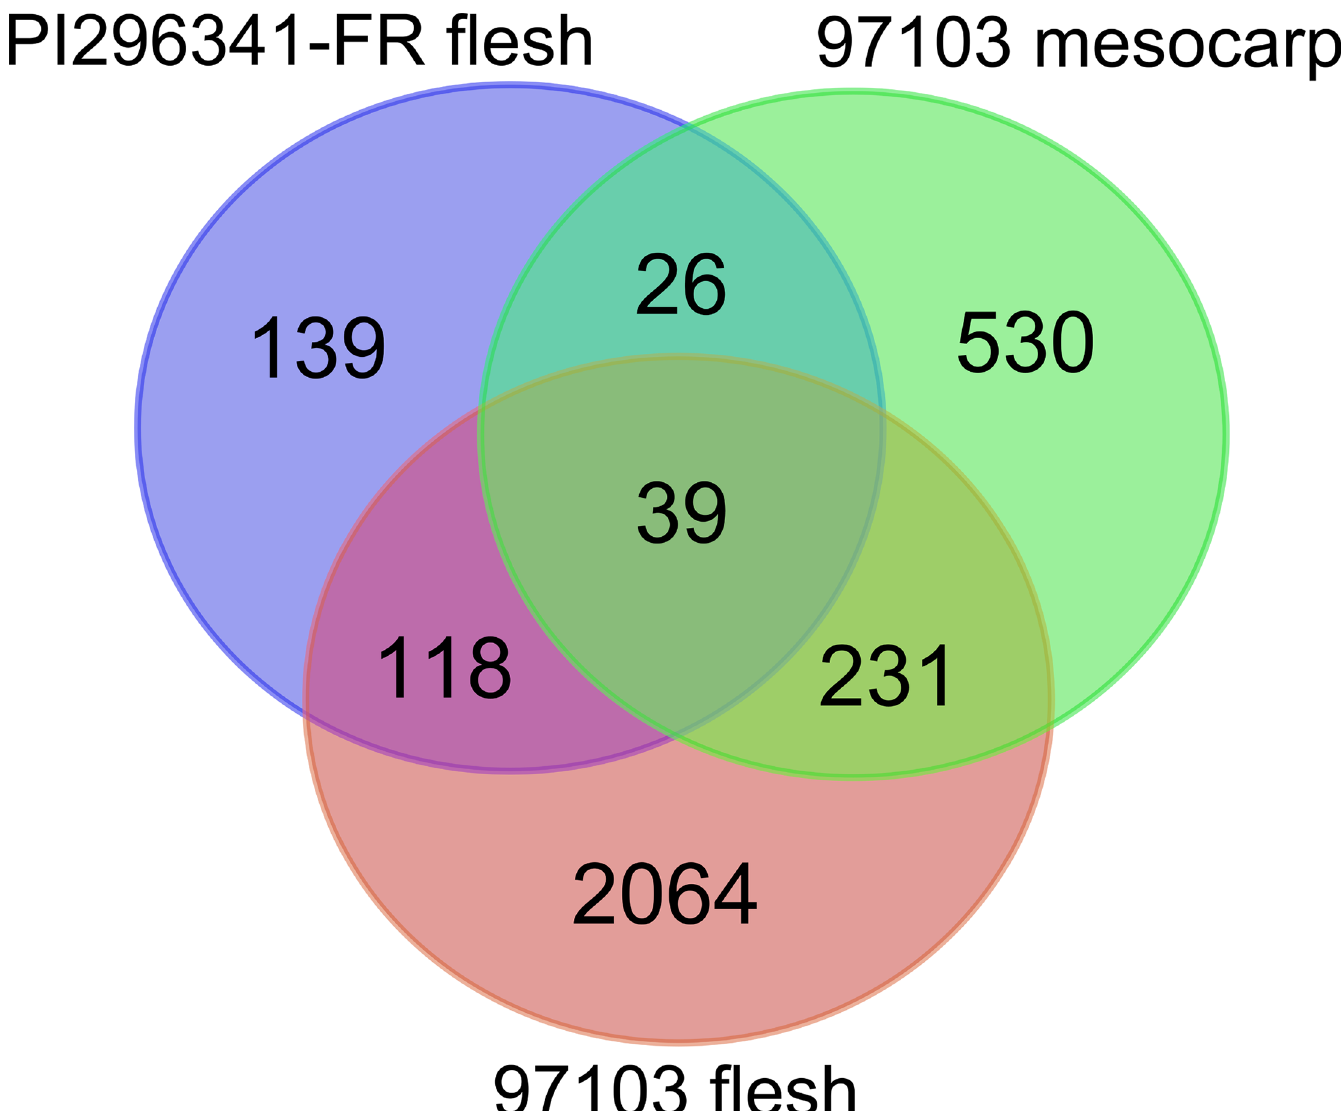
Fig 2. Venn diagram of differentially expressed genes in three tissues during watermelon fruit